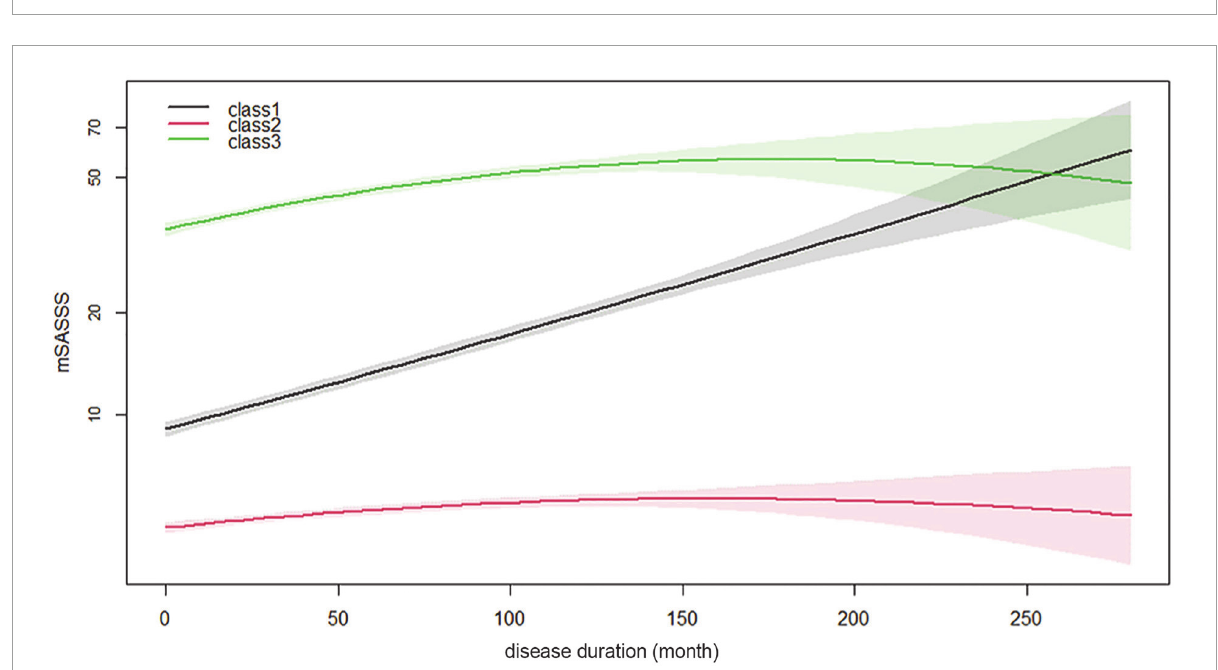
FIGURE3 Longitudinal mSASSS trajectory groups for disease duration. Time in month is shown along the x-axis, and logarithmic transformed total mSASSS is shown along the y-axis. The solid line represents the estimated mean in the same-colored area representing the 95% confidence interval. mSASSS, modified Stoke Ankylosing Spondylitis Spinal Score.